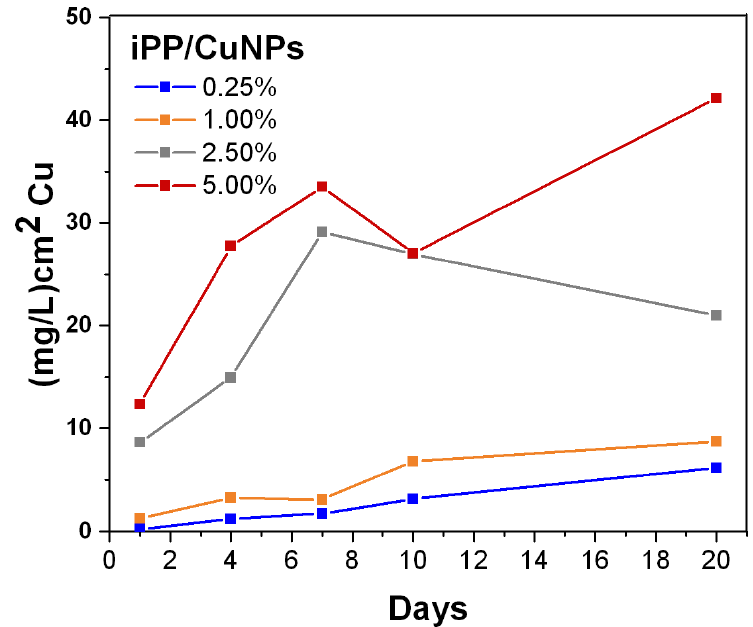
Figure 5. Concentration of released copper from iPP/CuNPs composites.